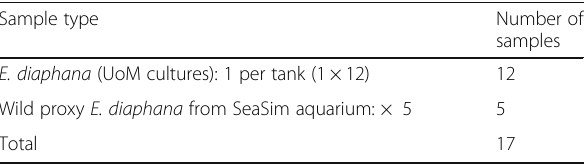
Table 2 Sampling summary for Symbiodiniaceae